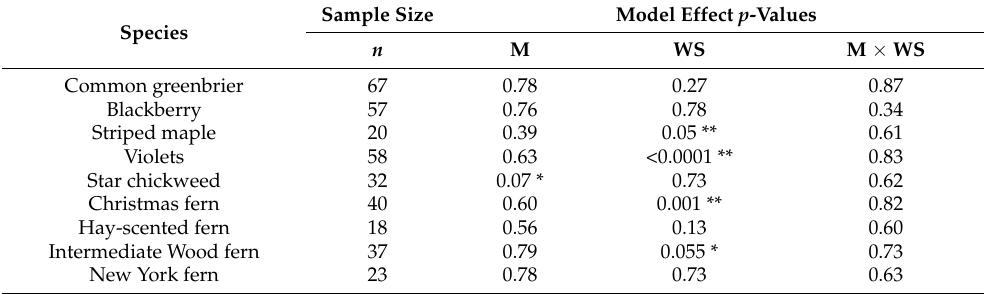
Table 2. Effects of overstory maple (M), watershed (WS), and their interaction (M × WS) on summer foliage NRA of individual, common herb-layer species at the Fernow Experimental Forest, West Virginia, USA. P -values shown resulted from an ANOVA on a dataset containing all four watersheds. The sample size ( n ) is given for each species; the maximum n is 72 (i.e., the number of study plots) since values had been averaged across all three summer sampling campaigns before analysis to minimize missing data